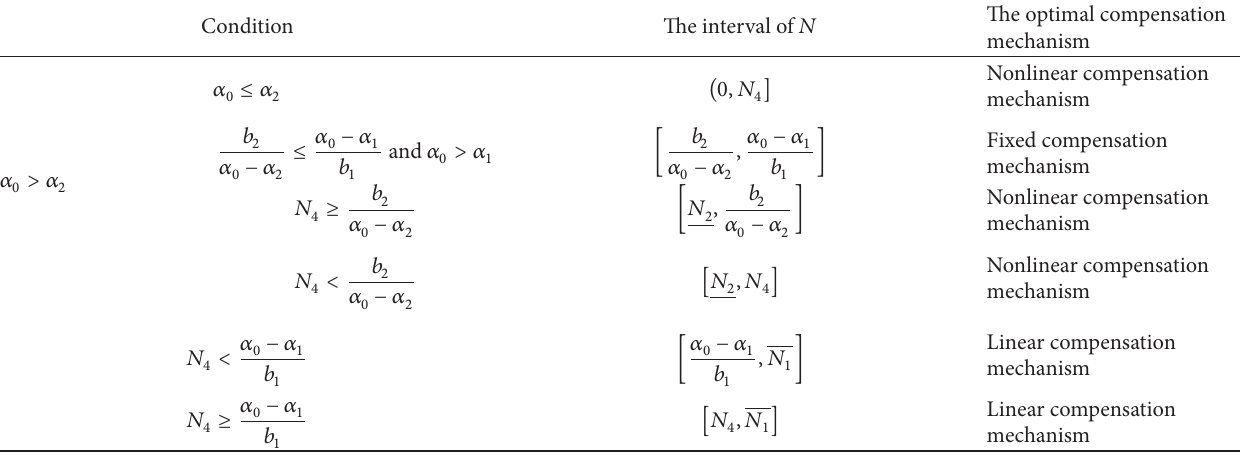
Table 4: The optimal compensation mechanism with different number of FLSPs.